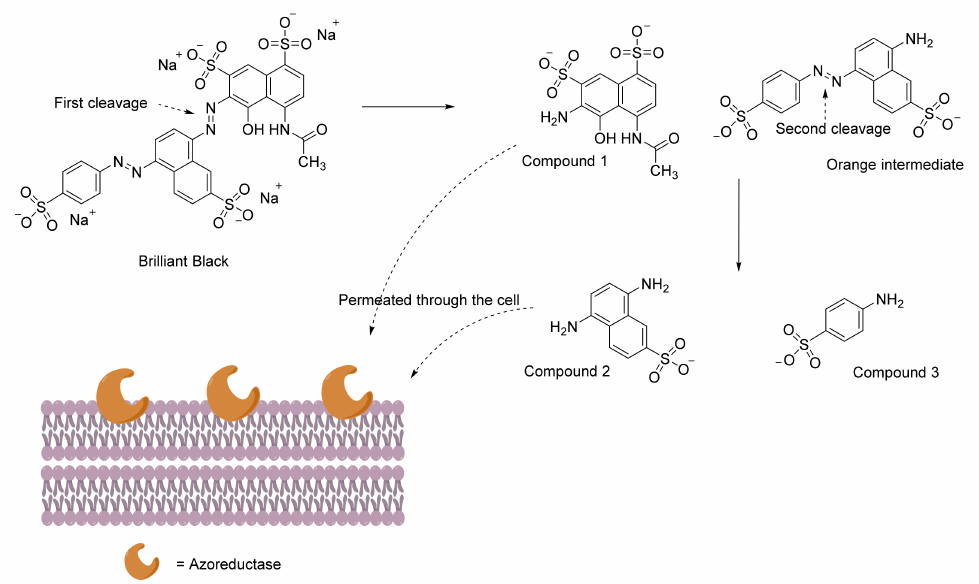
Figure 2. Proposed degradation pathway for Brilliant Black by Dermacoccus abyssi MT1.1 T while the degradation compounds or intermediates were reported earlier